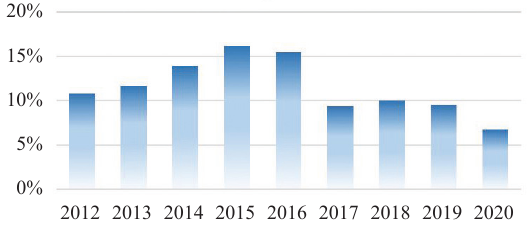
Figure 16. Percentage of road traffic accidents with heavy injuries with fixed speed